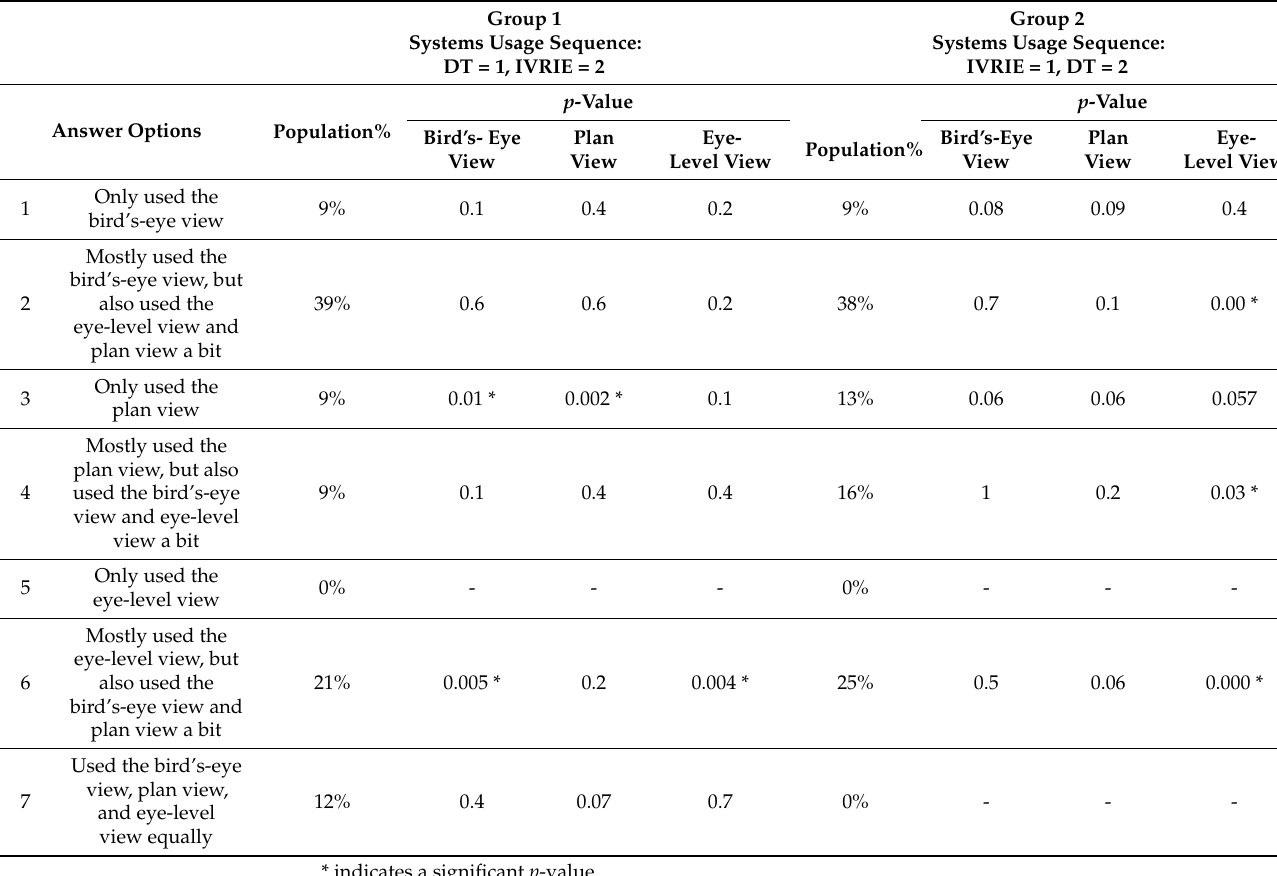
Table 2. Differences between the Perceived and Actual View Usage Patterns based on System Usage Sequence.